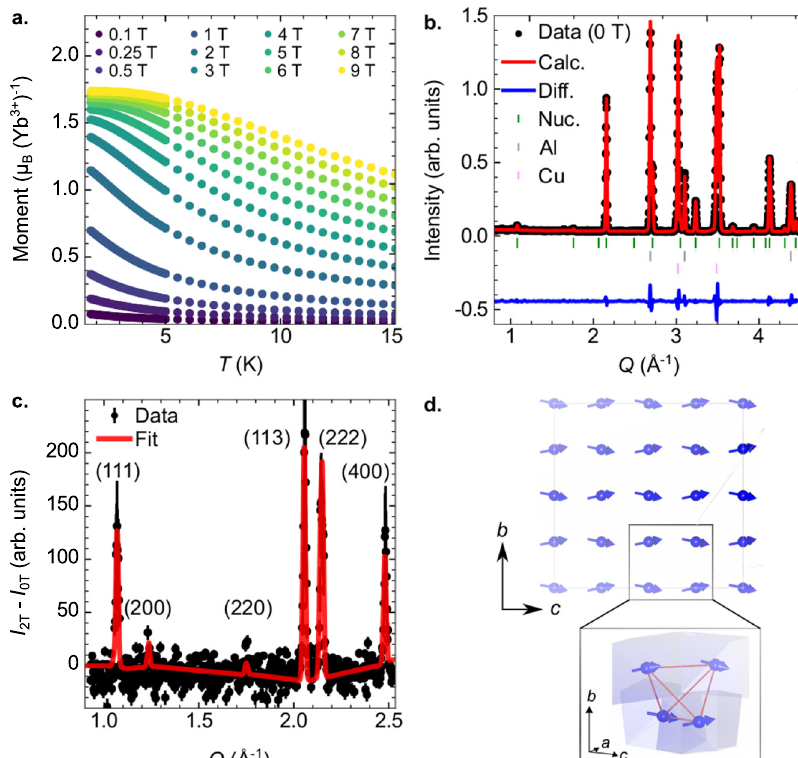
Fig. 3 Field-induced magnetic order in Yb 2 GaSbO 7 . a DC magnetic susceptibility data of Yb 2 GaSbO 7 for various applied fi elds. Note the development of a net ferromagnetic moment as the fi eld is increased. b Powder neutron diffraction data from HB-2A for Yb 2 GaSbO 7 measured at T = 1.2 K in zero fi eld. The red curve represents a Rietveld re fi nement of the data to the pyrochlore structure. No magnetic Bragg peaks are visible in this data. c 2 T − 0 T difference plot of the T = 1.2 K neutron powder diffraction data, which ensures that the fi eld-induced magnetic scattering can be isolated. A Rietveld re fi nement using the Γ 9 canted ferromagnetic structure is superimposed on the data. Uncertainties in the data are derived from Poisson statistics and represent one standard deviation normalised by the detector ef fi ciency correction. d A schematic of the canted ferromagnetic structure, with the inset depicting the spin arrangement on a single